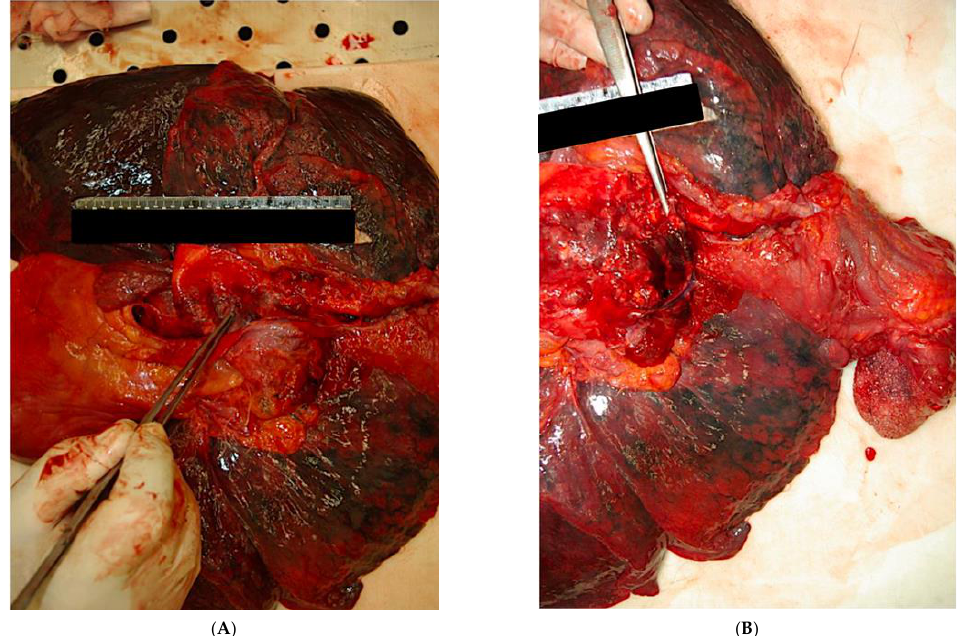
Figure 4. ( A , B) Macroscopic details of the heart and lungs. Macroscopic features of dissection recorded to autoptic examination.( A ) lateral vies; ( B )view from top. The heart, on the other hand, demonstrated thinned walls, a conspicuous increase in subepicardial adipose tissue, and the presence of working spots (hypopigmented areas) at the postero-medial wall of the left ventricle. In addition, increased myocardial thick- nesses were found at the left sections (anterior wall vs. 1.5 cm; lateral wall vs. 1.5 cm; posterior wall vs. 1.5 cm; interventricular septum 1.2 cm), in agreement with concentric hypertrophy and diffusely sclerotic valves (Figure 5A-C).